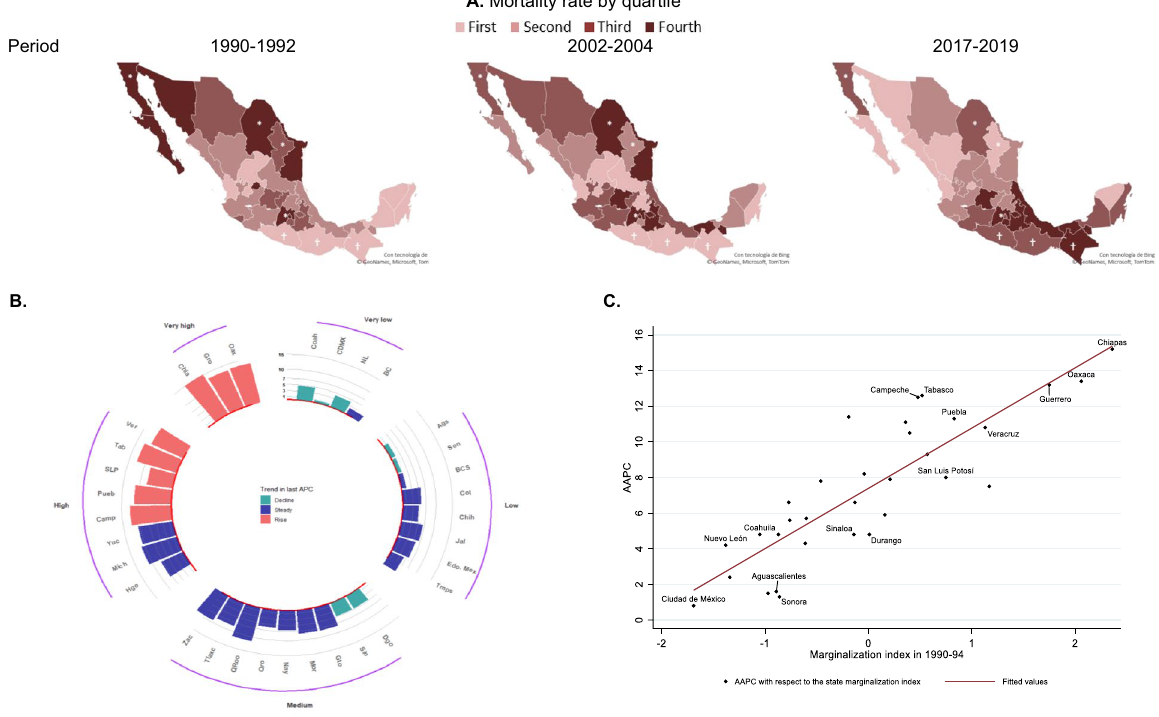
Figure 2. Age-adjusted mortality rates at the state level and correlation for the AAPC of diabetes mellitus mortality and marginalization in Mexico, 1990–2019. ( A ) The age-adjusted mortality rate for DM by state in Mexico categorized by quartiles during the periods 1990–1992, 2002–2004, and 2017–2019. Likewise, it shows the AAPC by state, categorized by marginalization quintiles ( B ). The scatter plot shows the state AAPC with respect to the marginalization index during the 1990–1994 period. States that showed a significant trend ( p < 0.05) in their last APC were labeled with their name ( C ). *States that predominated in the very low marginalization quintile throughout the period; † states that predominated in the very high marginalization quintile throughout the period. DM diabetes mellitus, APC annual percentage change, AAPC average annual percentage